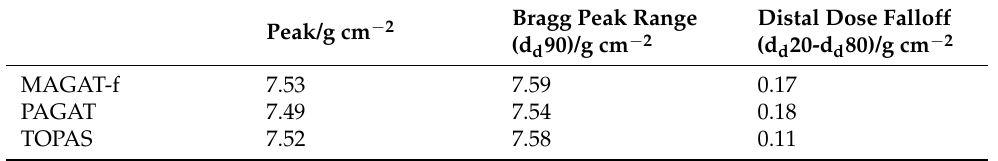
Figure 3. ( a ) Irradiated polymer gel dosimeter and ( b ) five R 2 maps of the gel at different planes (100.2 MeV). Table 3. Comparisonof100.2MeVprotonBraggpeakbetweenpolymergeldosimetersandMC